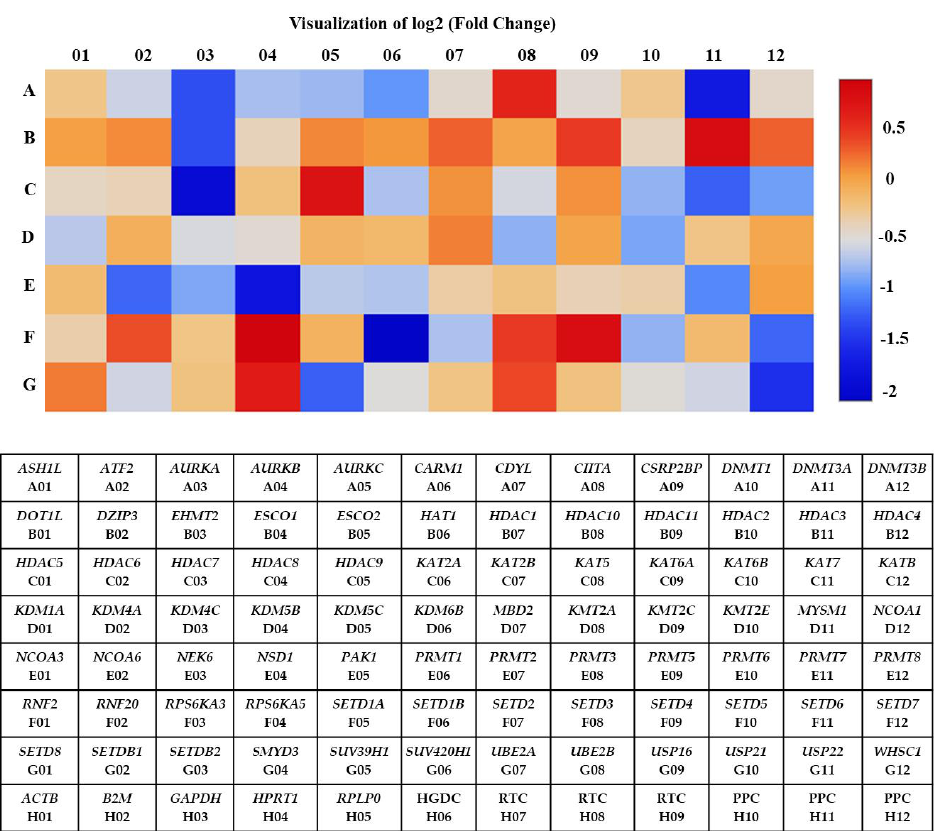
Figure 2. The heat map shows differentially expressed genes in A2780 cells after SAHA treatment. Red and blue color blocks represent high and low-level expressions, respectively. Human epigenetic chromatin modification enzymes gene table used in RT 2 profiler PCR array experiments.